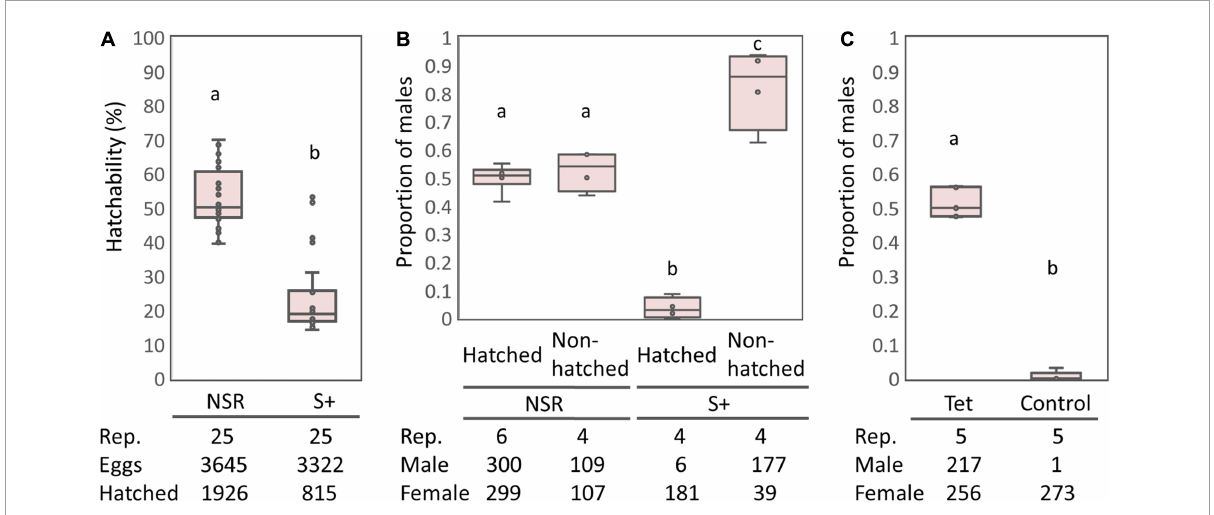
FIGURE1 Egg hatching rates and sex ratios of the S+ line of Homona magnanima. (A) Egg hatching rates of 25 egg masses for each of the NSR and S+ lines (total 3,645 and 3,322 eggs, respectively). (B) Proportion of males among the hatched larvae and the unhatched pharate larvae. (C) Proportion of males of the subsequent generation after tetracycline treatment. Tet, tetracycline treatment; Control, non-treated control. The horizontal bar within the box represents the median. The upper and lower hinges of the box indicate upper quartile and lower quartile, respectively. Sample sizes are indicated below the panels. Different letters indicate significant differences between groups (Steel–Dwass test, P <